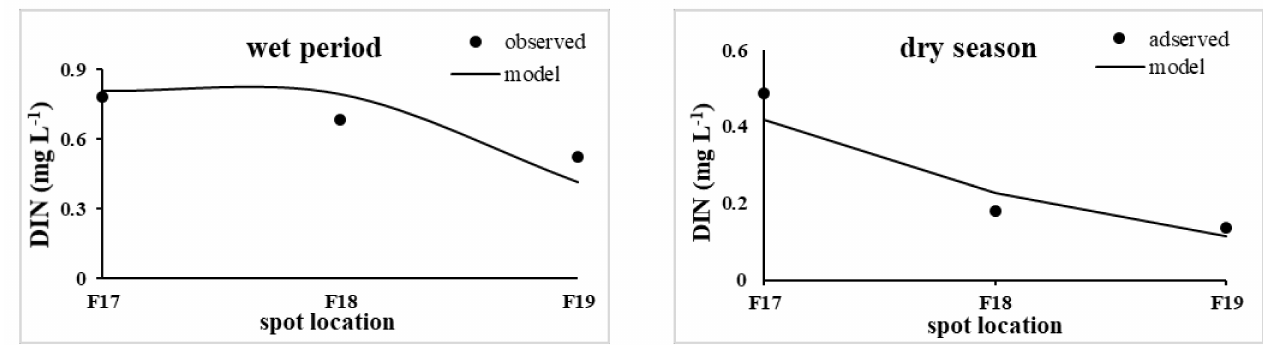
Figure 6. Calibration results of the DIN concentration in the coastal waters of the Minjiang Estuary (F17, F18, and F19 represent the CI, ME, and OME,